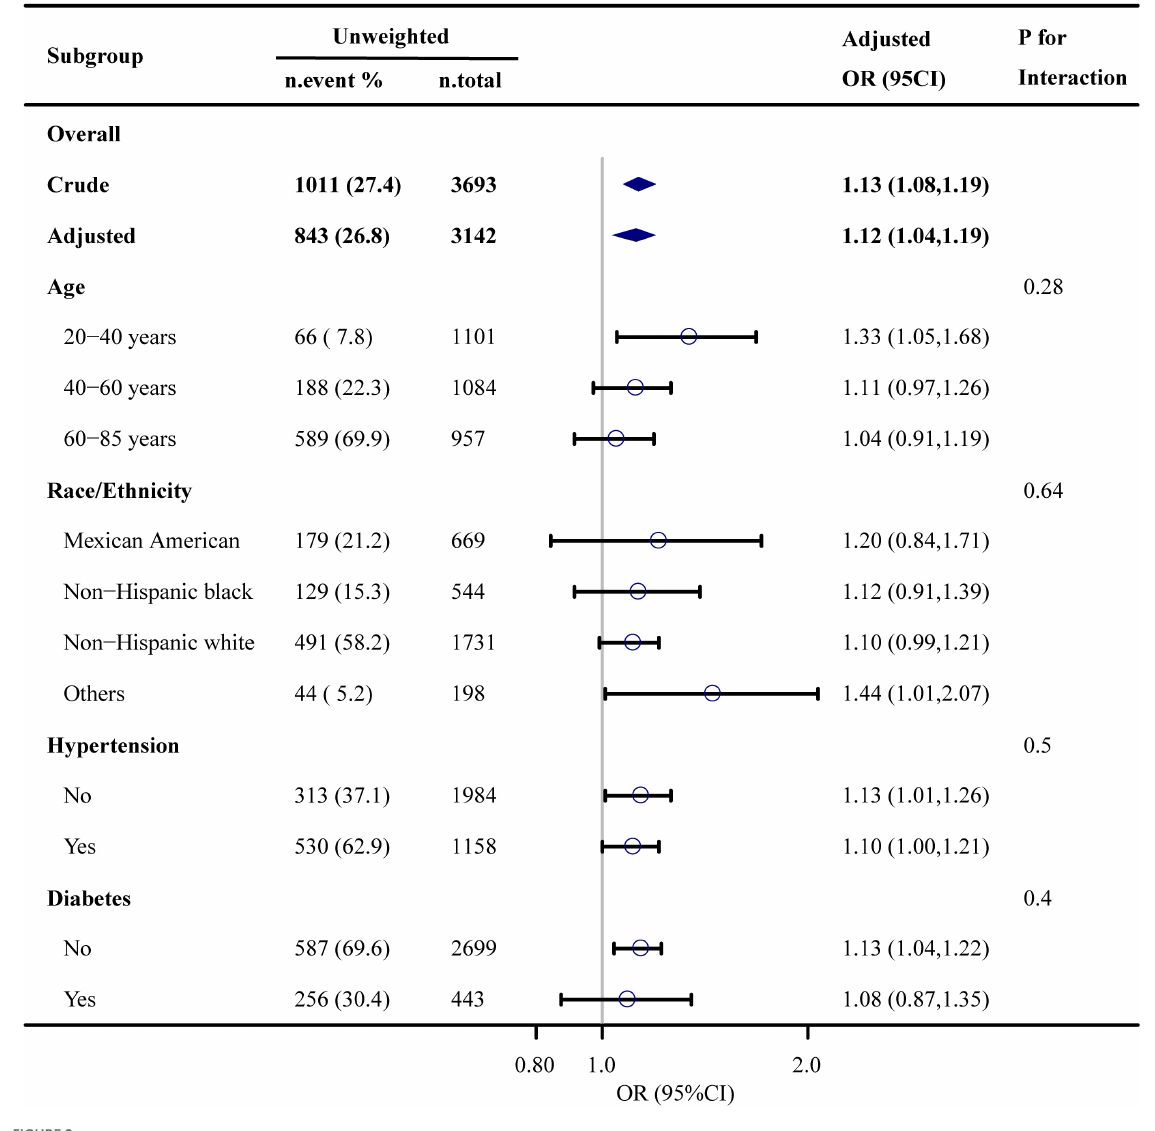
FIGURE2 Association between dietary inflammation index and erectile dysfunction. Each stratification was adjusted for age, race and ethnicity, educational level, physical activity, smoking status, drinking status, BMI, hypertension, diabetes, cardiovascular disease, hypercholesterolemia, and eGFR, except the stratification factor